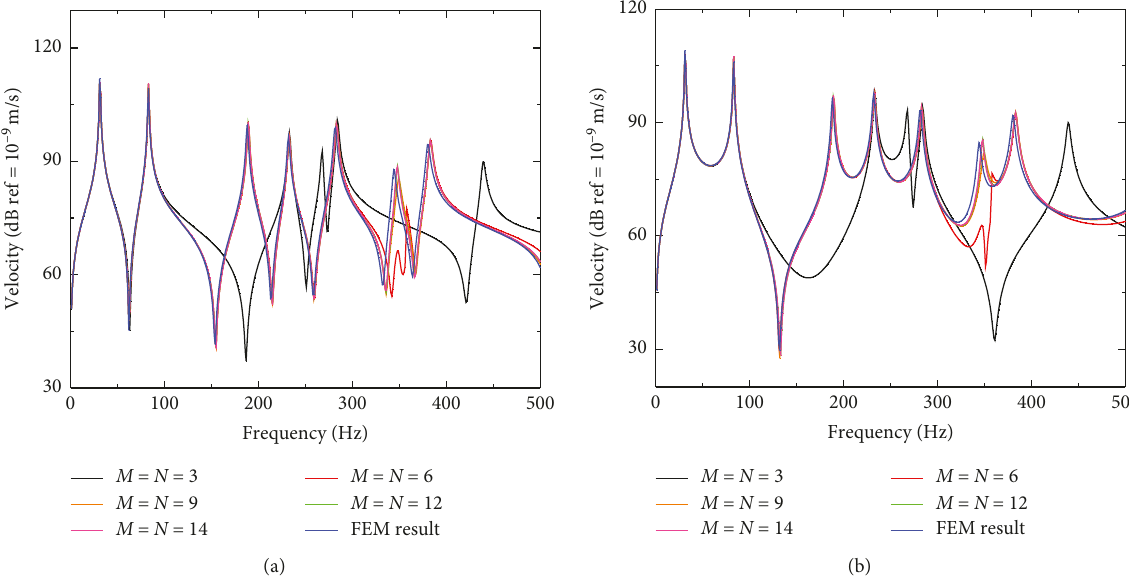
Figure 4: Convergence of velocity response for rectangular plate with one central x -wise beam and one central y -wise beam under local uniform pressure ( p w � 1). (a) Point A (1 m, 0.5m). (b) Point B (0.5m, 0.5